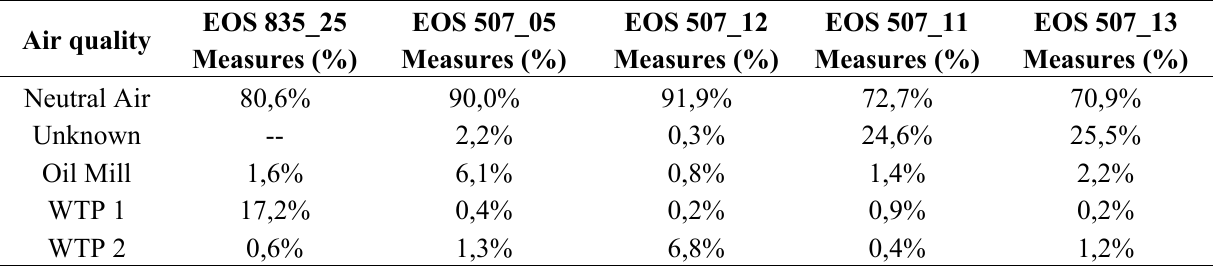
Table 3. Percentage of measures attributed to the different olfactory classes during the monitoring